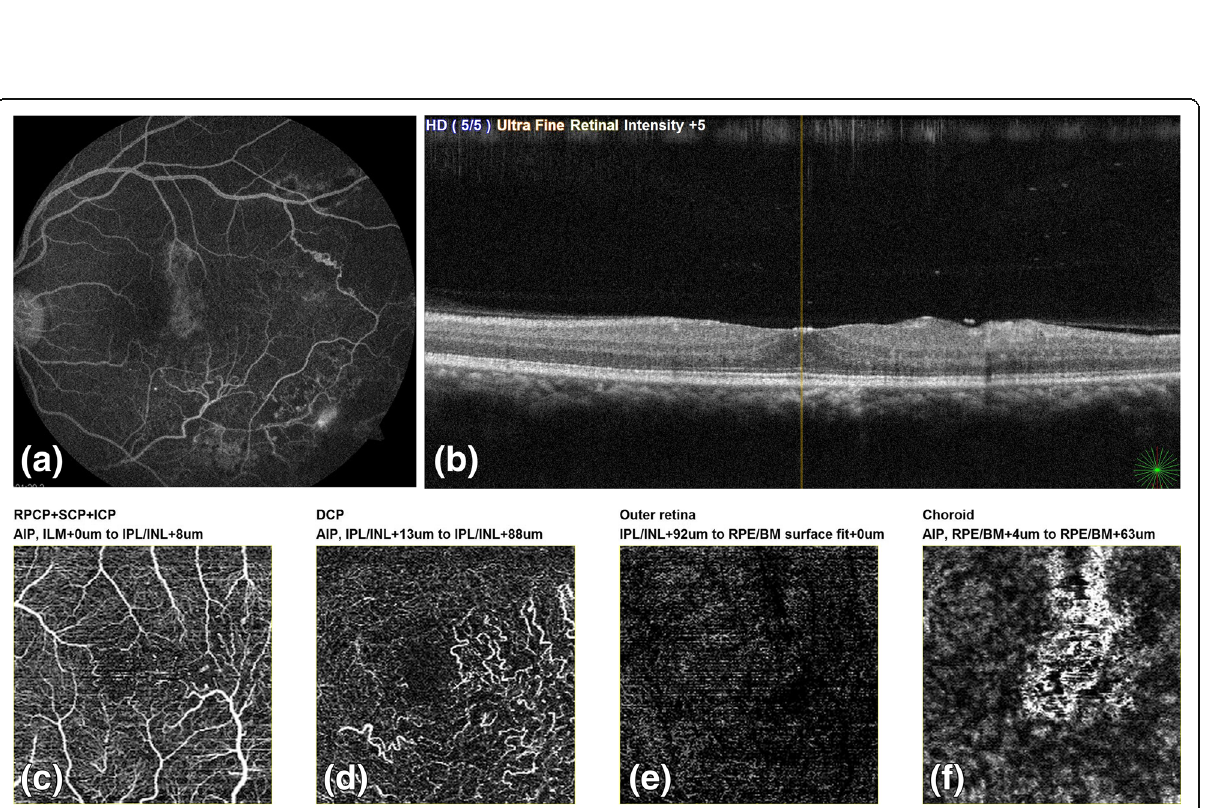
Fig. 4 23 years male vision left eye 6/24; (a) FA: distortion at macula due to inferotemporal branch retinal vein occlusion with ERM (b) OCT: shows ERM (c) OCTA at SCP (d) OCTA at DCP (e) OCTA at outer retina (f) OCTA at choroid level shows irregularity of vessels at SCP and